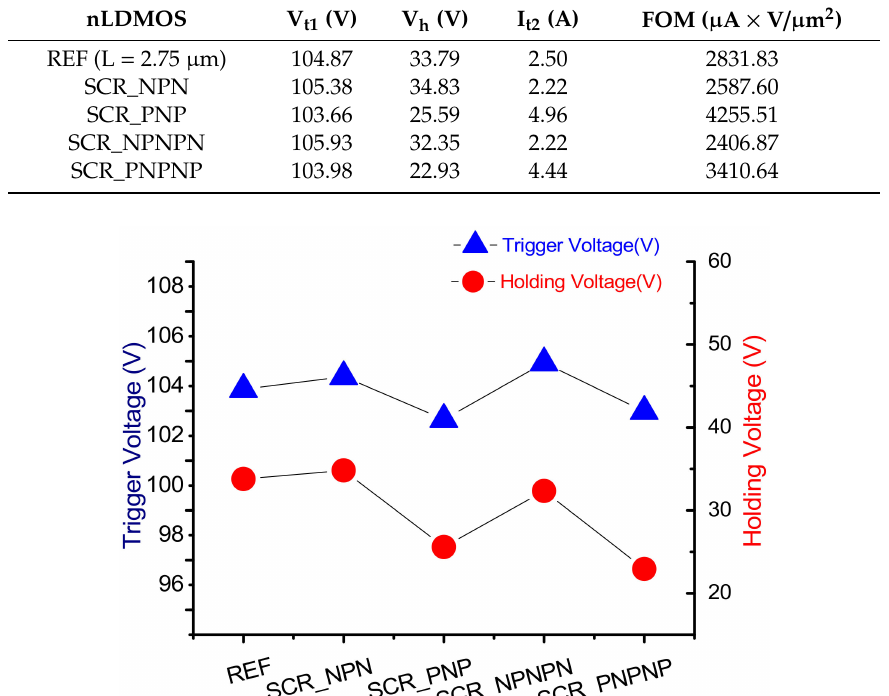
Table 4. Snapback extracted parameters of HV nLDMOSs with embedded SCR modulation.